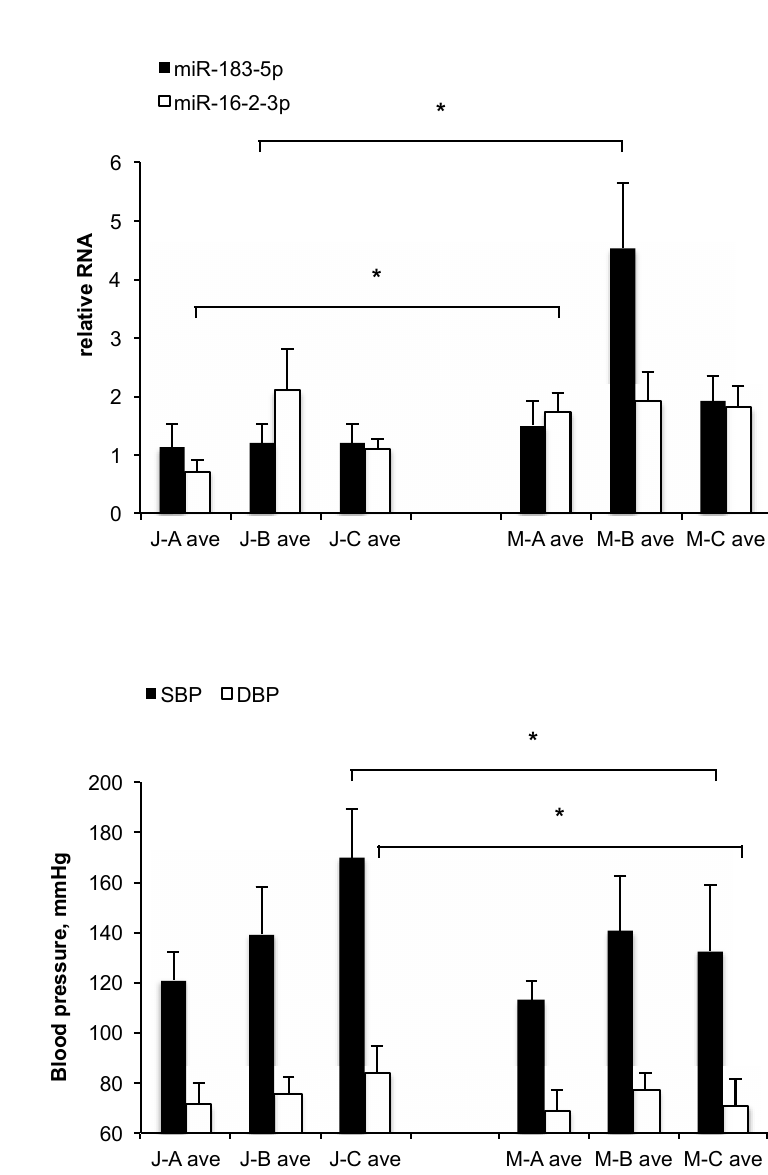
Figure 2. ( A ) Relative mean levels of plasma miR-183-5p and miR-16-2-3p in the three subject groups (A, B, C) with ethnic a ffi liation of Muslim Arab (M) or Jew (J), as measured by qRT-PCR. The data are normalized (the levels of each miRNA can be compared between groups, but the levels of di ff erent miRNAs cannot be compared). Bars, standard error. Numbers of samples in each category appear in Supplementary Table S1. *: p < 0.05 ( t -test). ( B ) Mean blood pressure levels (in mmHg) of the three subject groups (A, B, C) with ethnic a ffi liation of Muslim Arab (M) or Jew (J). SBP, systolic; DBP, diastolic. Bars, standard error. Numbers of samples in each category appear in Supplementary Table S1. *: p < 0.05 (t-test).